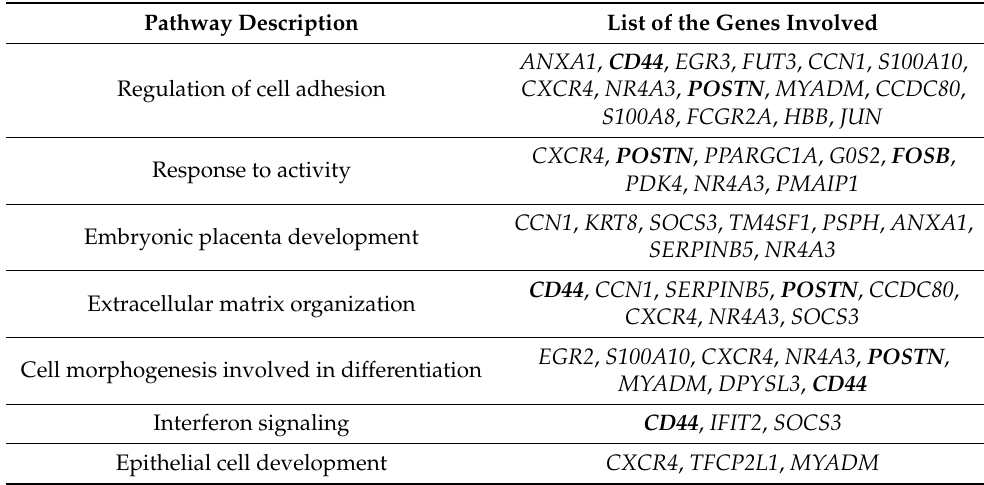
Table 7. Main pathways and their genes from the upregulated functional clusters (analyzed with Metascape) in asthmatics versus healthy controls. The genes represented in bold indicate an overlap with the lung cancer